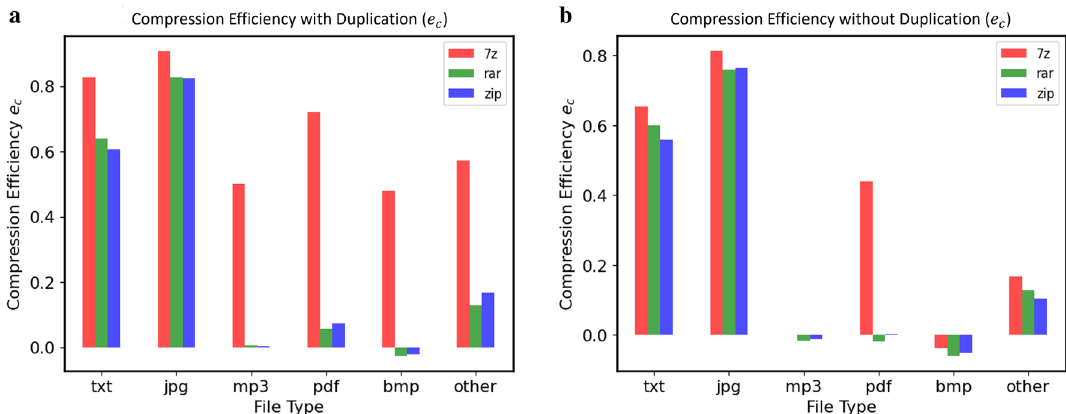
Figure 8. Compression efficiency (data types). This figure shows how the e c values of the three selected compression methods are changed with respect to six types of test data ( txt , mp3 , jpg , pdf and other files, such as exe , dll , html , etc.) for the cases—the data is either redundant ( a ) or not ( b ). The data sizes used by these two figures are 4 MB (w/ redundancy) and 2 MB (w/o redundancy), respectively. In particular, ( a ) shows that the overall compression efficiency of 7z is best among the three, and the relative effects of rar and zip are different in different situations. From ( b ), one can still see that 7z is the best, but its advantage is diminished when the data redundancy is